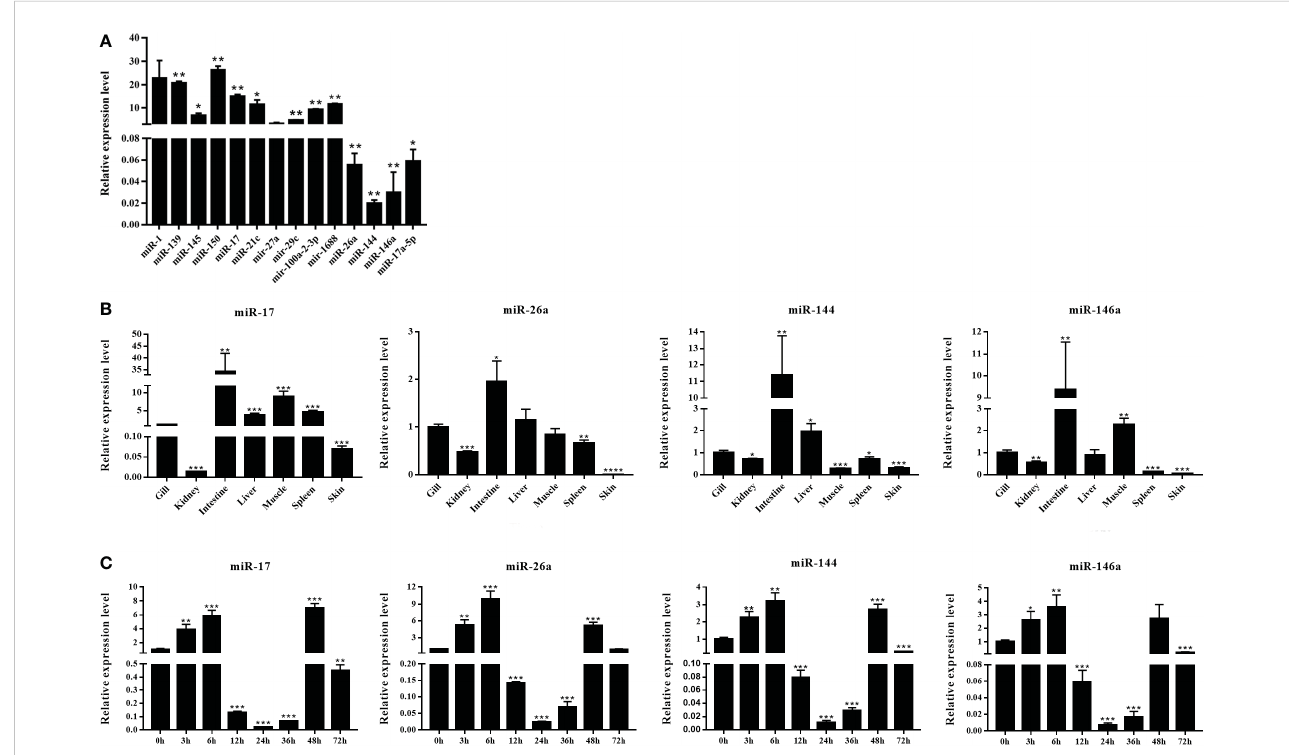
FIGURE 5 Expression analysis of the differentially expressed miRNAs (DEMs) in normal and Aeromonas hydrophila -infected Carassius auratus . (A) Validation of the relative expression using quantitative real-time PCR (qRT-PCR) of the 14 DEMs in the gills. (B) Tissue distribution of four DEMs — miR-17, miR-144, miR- 146a, and miR-26a — in healthy C auratus . (C) Temporal expression of the four key miRNAs in infected gill tissues. All data were from three independent triplicate experiments (* p < 0.05, ** p < 0.01). ***P<0.001,